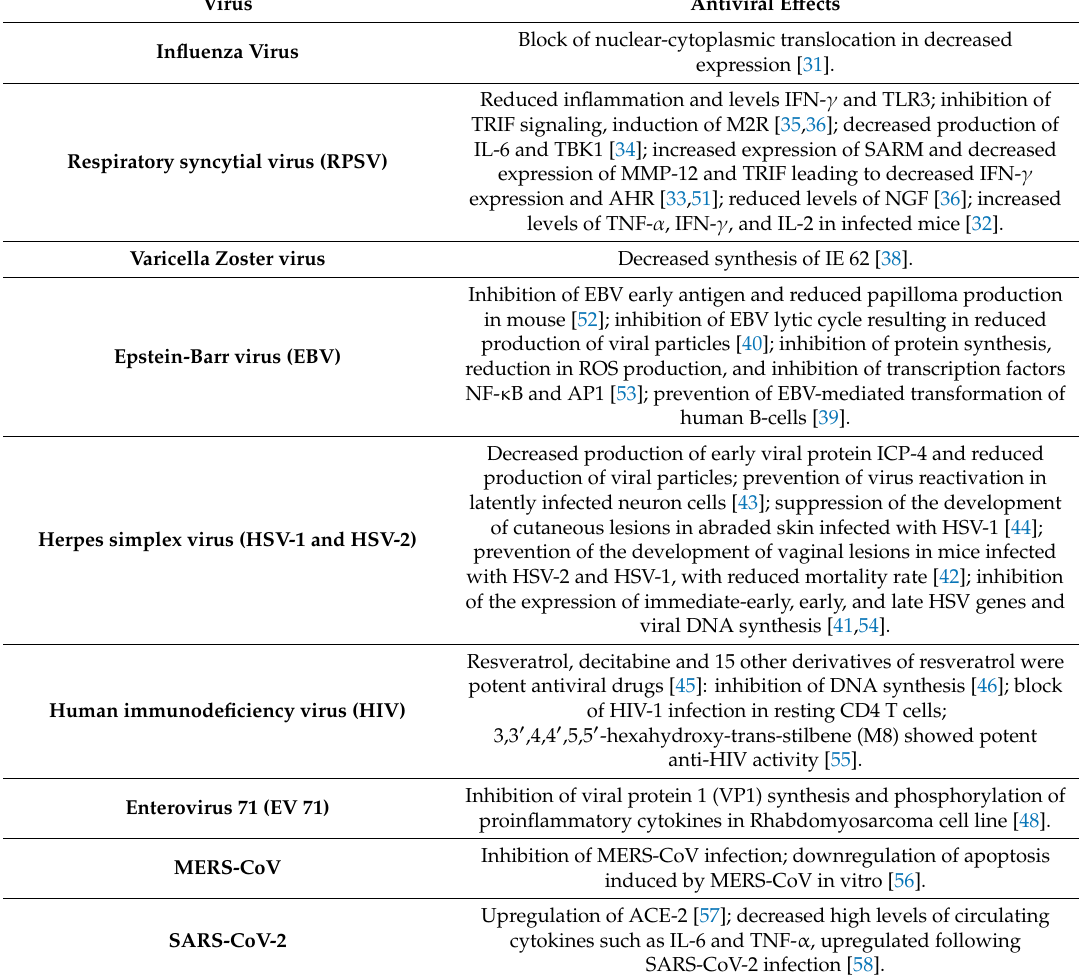
Table 1. Antiviral e ff ects of